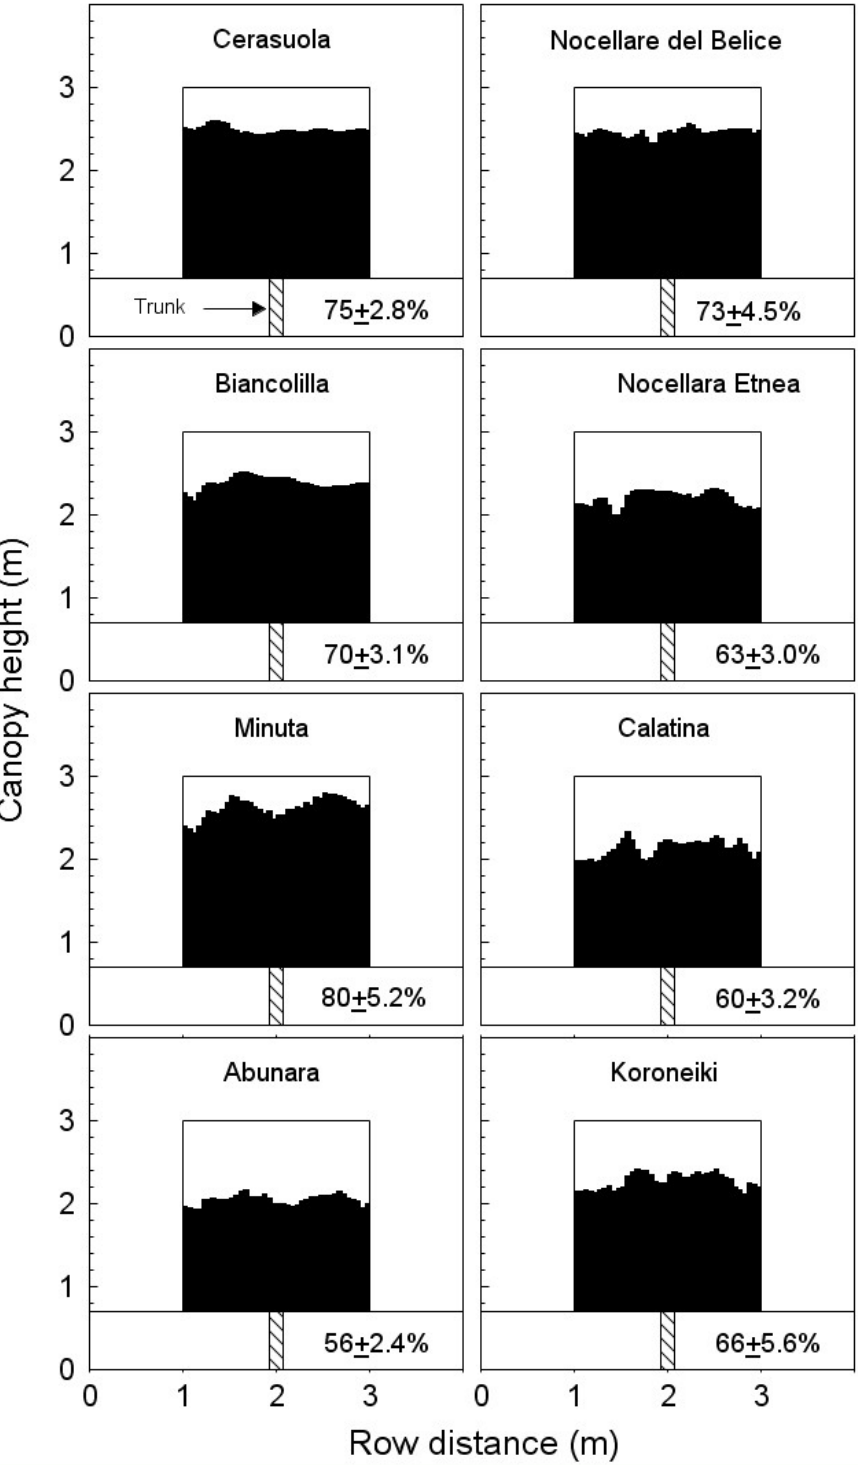
Figure 3. Canopy height profile of olive trees of different cultivars planted at 4 × 2 m. The average canopy height profile of 10 trees is reported for each cultivar. In each section, the percentage of the canopy wall filled by the canopy is also reported. The canopy wall (2 × 2.3 m) was calculated considering the distance between trees along the row (2 m), a trunk height of 0.7 m and a canopy height considered optimal for the agronomic management (3 m).